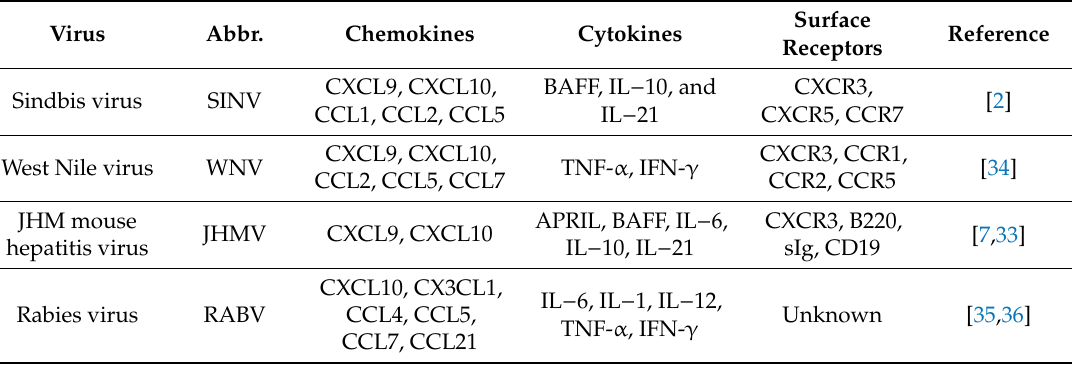
Table 2. Chemokines, cytokines, and surface receptors associated with antibody-secreting cell (ASC) recruitment and maintenance in the central nervous system